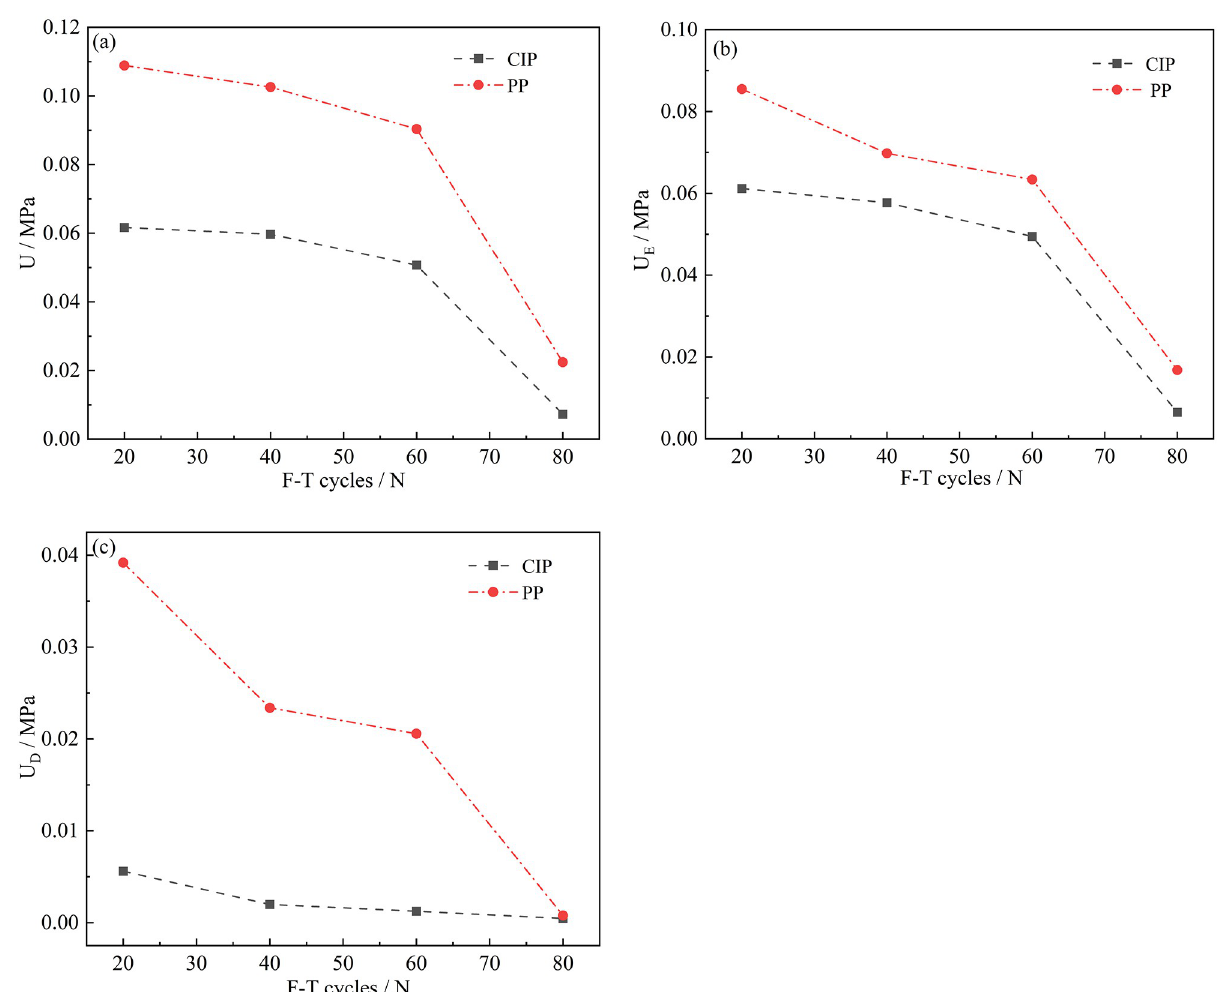
Fig 4. F-T effects on energy at various characteristic points. (a) Total energy (b) Elastic energy (c) Dissipative energy. ) were the positions of the selected feature points on the complete stress-strain curve (Fig σ c 1F).